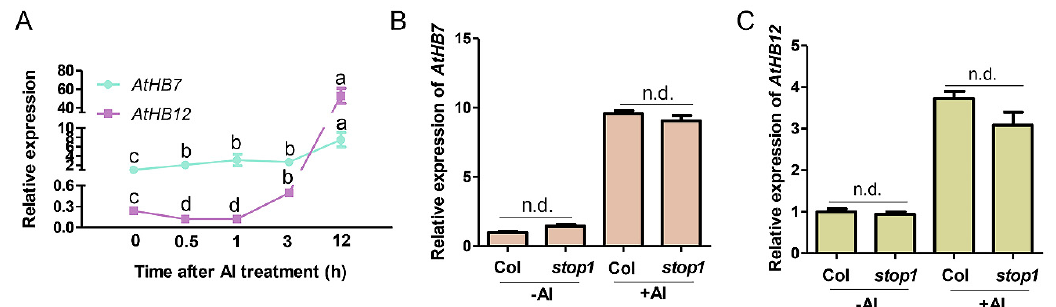
Figure 1. Two HD-Zip Ⅰ transcription factors AtHB7 and AtHB12 response to Al stress independent of STOP1 regulation. ( A ) Time-course analysis of AtHB7 and AtHB12 relative expression in roots in response to 20 μ M Al exposure. The relative expression was normalized to ACTIN2 expression and AtHB7 expression untreated with Al was set as 1. Relative expression of AtHB7 ( B ) and AtHB12 ( C ) in roots of wild type and stop1 mutant in response to 20 μ M Al exposure. Data are means ± SD ( n = 3). Different letters indicate significant differences by Tukey’s test.